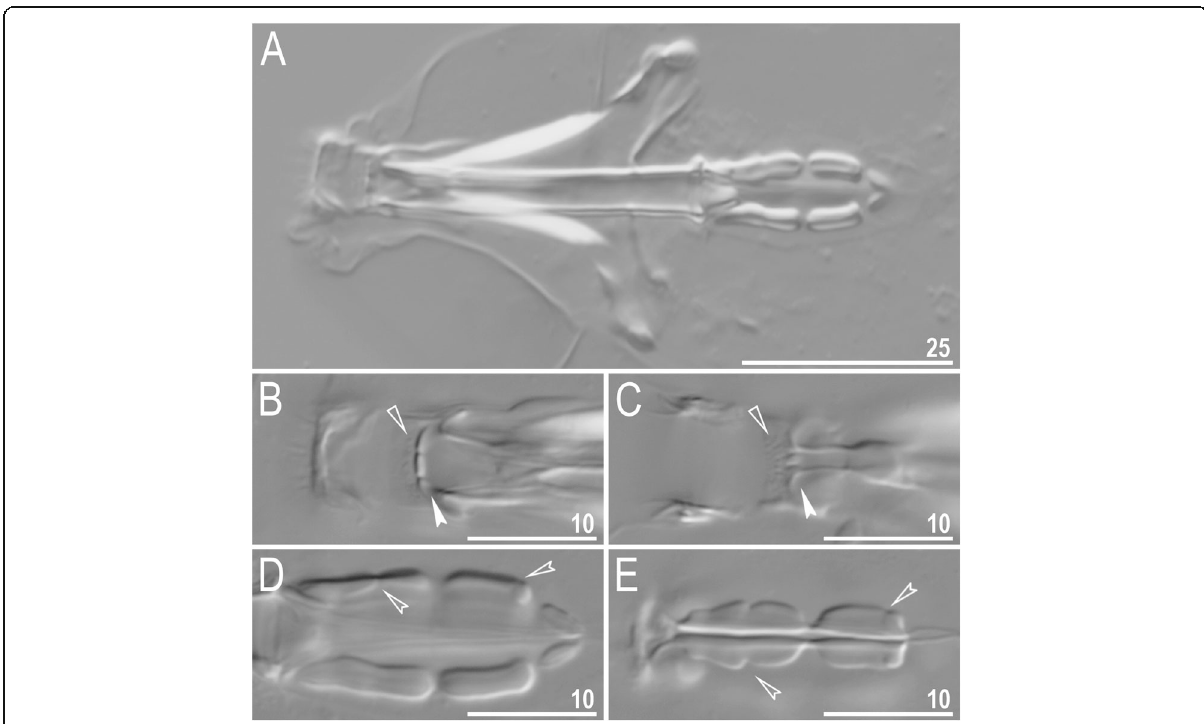
Fig. 34 Macrobiotus margoae sp. nov. from USA (US.057) – buccal apparatus seen with LCM: a – an entire buccal apparatus; b – c – the oral cavity armature, dorsal and ventral teeth, respectively; d – e – placoid morphology, dorsal and ventral placoids, respectively. Empty flat arrowheads indicate the second band of teeth, filled indented arrowheads indicate the third band of teeth, and empty indented arrowheads indicate central and subterminal constrictions in the first and second macroplacoid. Scale bars in μ m